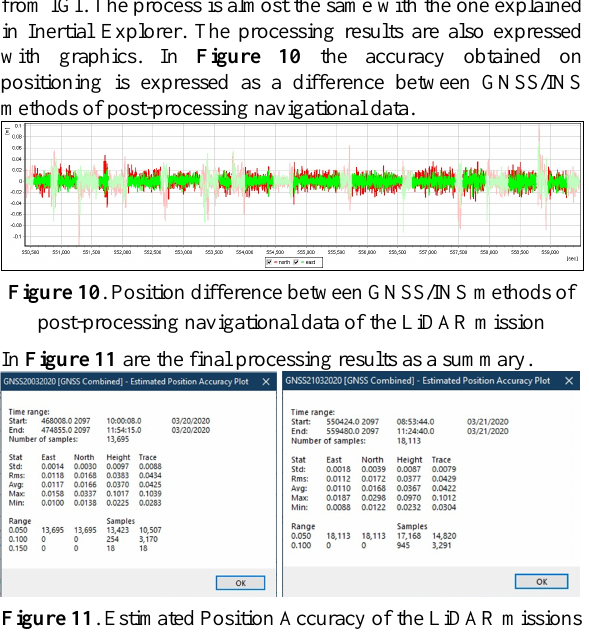
Figure 13 . Primary classification of the noise